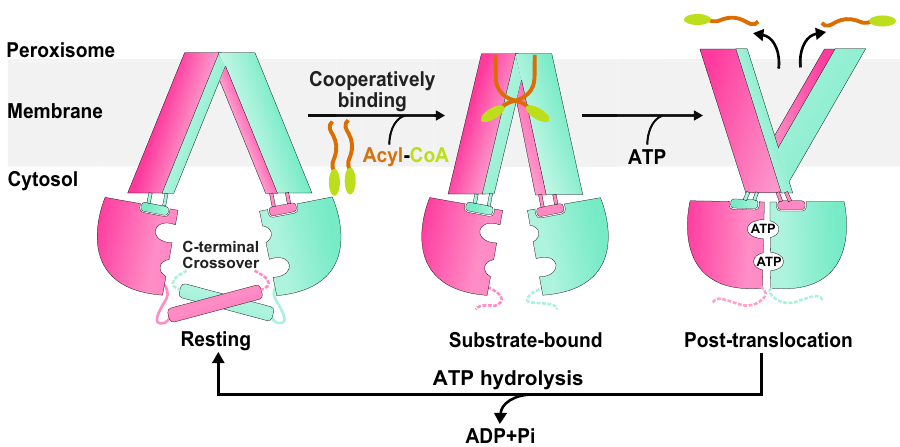
Fig. 5 A working model for the ABCD1-mediated fatty acyl-CoA translocation. Schematic illustration of the transport cycle of ABCD1, inferred from the three resolved structures. The apo-form ABCD1 adopts an inward-facing conformation, with the two NBDs properly separated via the C-terminal helical crossover (resting state). Cooperative substrate binding drags two TMDs approaching each other, resulting in a narrowed inward-facing transport cavity (substrate-bound state). Upon ATP binding, the NBDs approach each other and dimerize, making ABCD1 in an outward-facing conformation, and facilitating the substrate release into the peroxisome (post-translocation state). Finally, the hydrolysis of ATP resets ABCD1 to the resting state, and ready for another transport cycle. The CoA portion and fatty acyl chain of fatty acyl-CoA are shown as green ovals and brown curved lines,